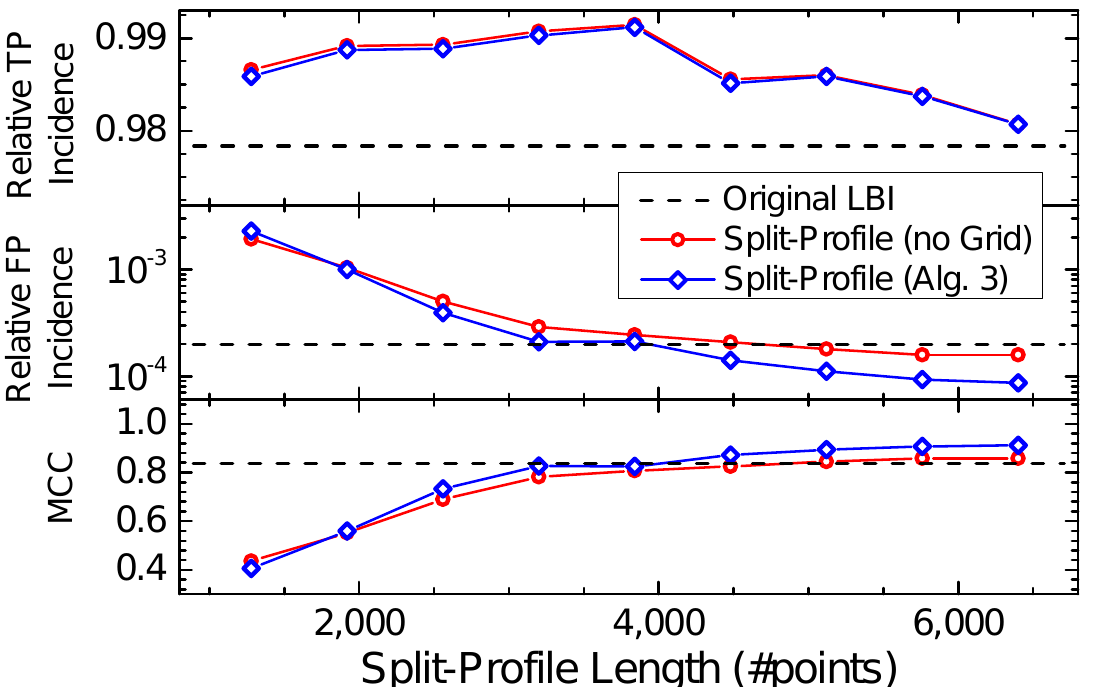
Figure 4. Performance of the split-profile methodology for varying split-profile lengths, in number of points. The original profiles, from which the sub-profiles were derived, contained 15,000 points. To increase the statistical validity of the analysis, 1000 datasets were generated according to Algorithm 2. The baselines—in black dashes—correspond to the results of the original (non-split) LBI. Above 4500 points, the performance recovered and slightly increased even when the λ -grid (Lines 7 through 10 in Algorithm 3) was not performed, as evidenced by a higher MCC